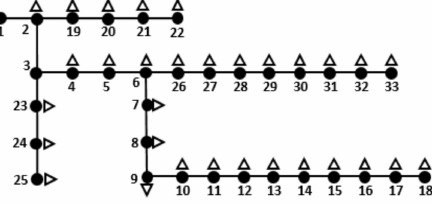
Figure 11. The IEEE 33-bus test